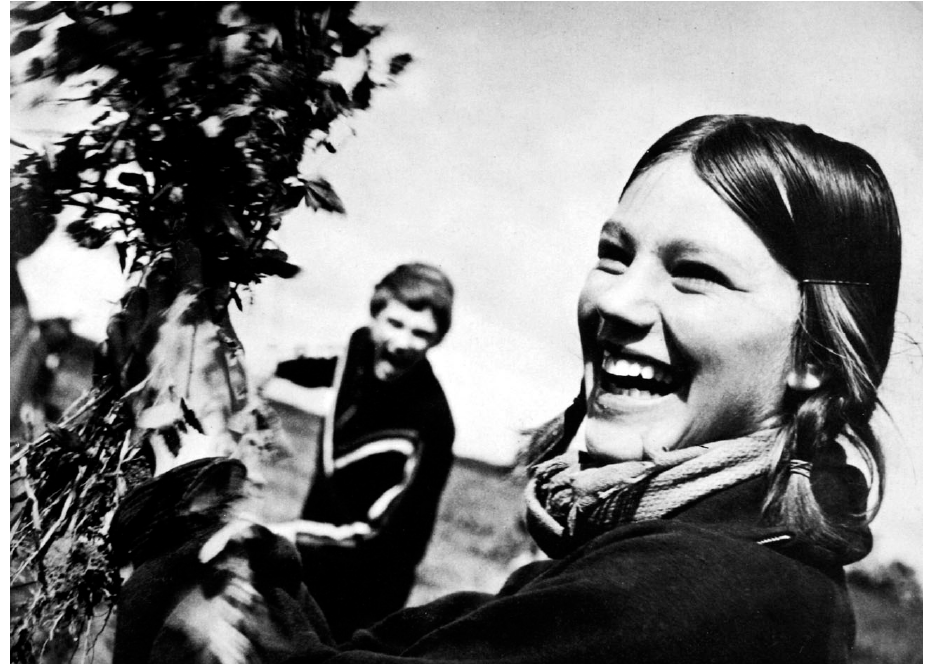
Figure 1. Carla Arnold, Dem Unkraut zu Leibe (Bearing down the weeds), 1960. Photo Credits: Carla Arnold.